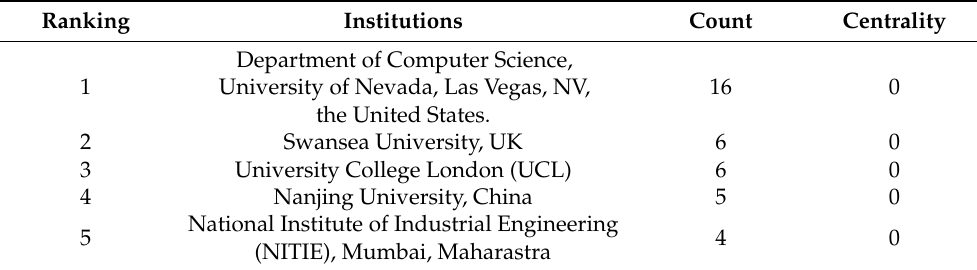
Table 2. Top 5 institutions according to the number of publications.